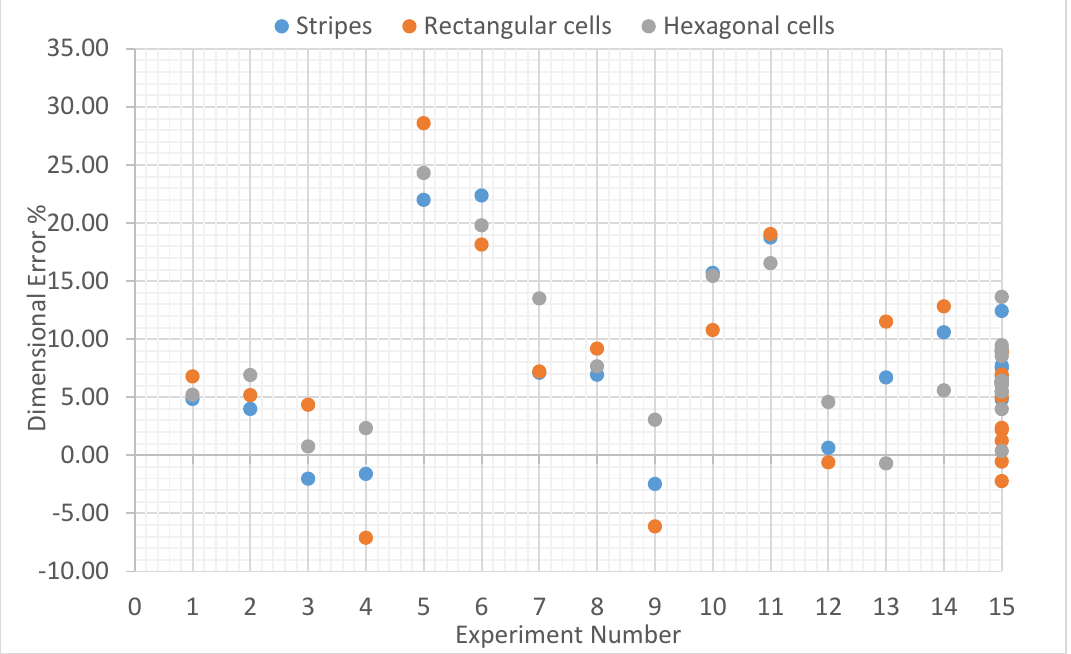
Figure 7. Average measurements of dimensional error % amongst three scan strategies for a 60 µm layer thickness.